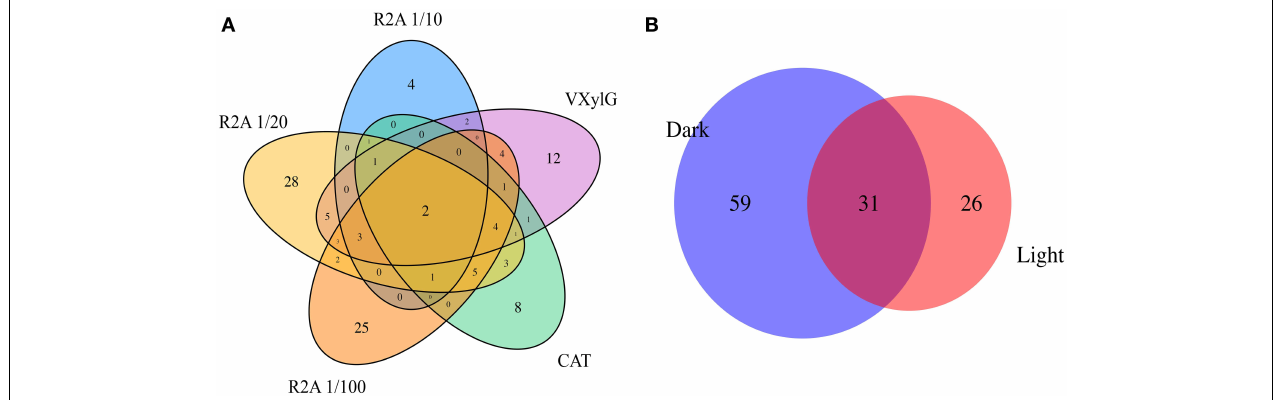
FIGURE 3 | Venn diagrams showing the intersection of isolate clusters found in (A) the different media (i.e., 1/10 R2A, 1/20 R2G, 1/100 R2G, CAT, and VXylG) and (B) pre-incubation conditions (Dark and